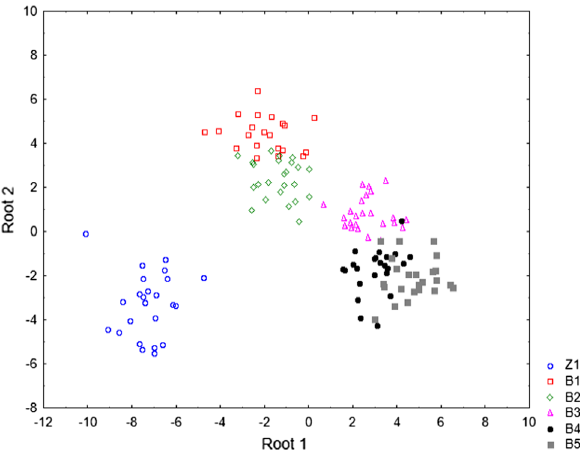
Fig. 2 Multivariate discriminant analysis (MDA) testing for differ- ences among the six sampling public supply